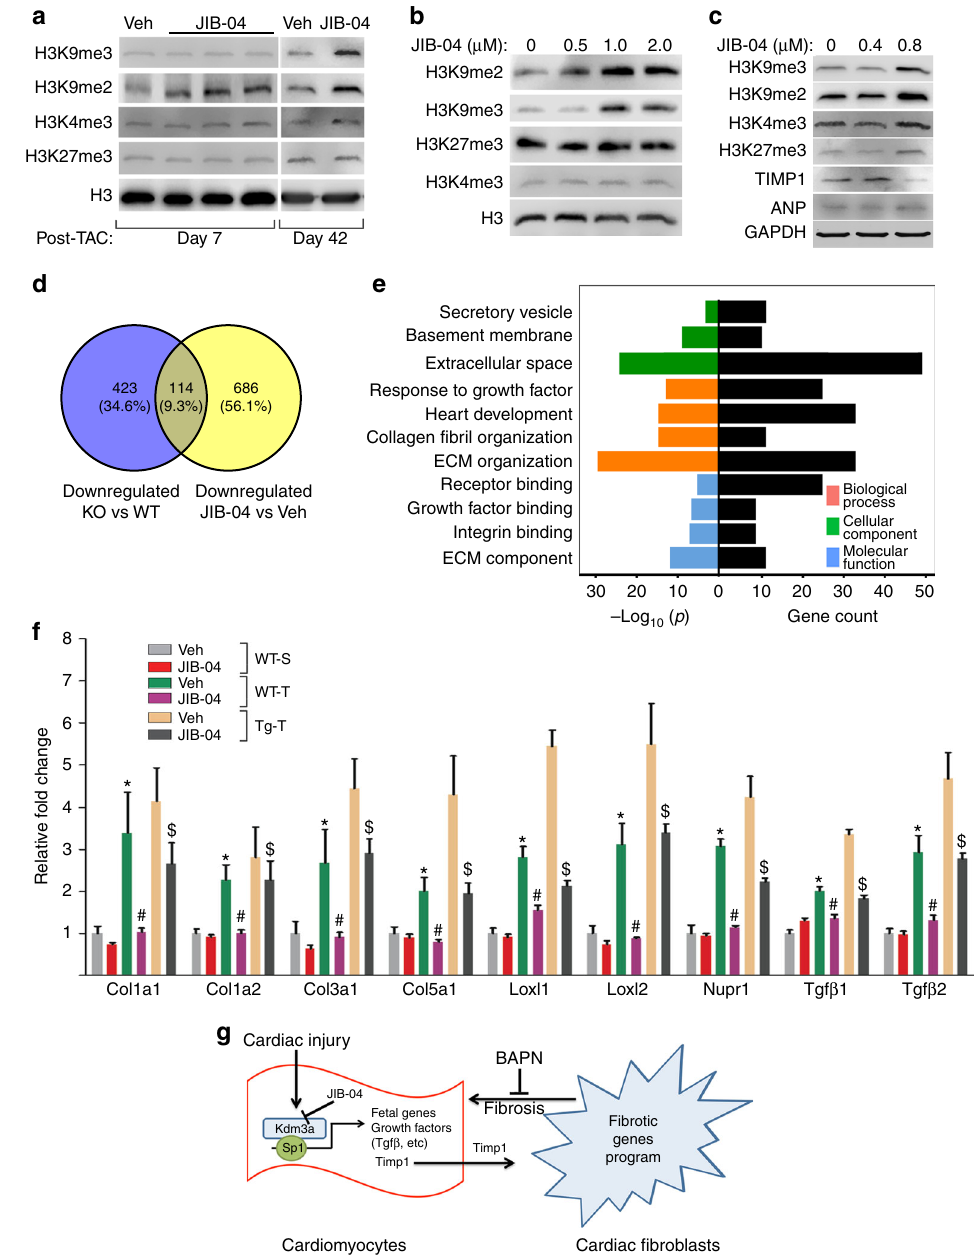
Fig. 8 JIB-04 targets H3K9me2 demethylase and fi brotic gene program. a Western blots of indicated proteins in lysates from WT mouse hearts treated with vehicle (Veh) or JIB-04 harvested at day 7 and day 42 post-TAC surgeries. b , c Western blots of indicated proteins from lysates of NRVMs ( b ) and human iPSC-CM ( c ) treated with various concentration of JIB-04. d Venn diagram showing overlapping of downregulated gene sets between KO vs WT and JIB-04 vs Veh treated mice. e GO analysis of 114 overlapping genes in d , showing signi fi cant enrichment of gene set in ECM and growth factor/integrin signaling. f qRT-PCR of representative genes in d . n = 3 ± SEM, *, # , $ , p < 0.05 (ANOVA). *, WT TAC vs WT Sham. # , JIB-04 WT TAC vs Veh WT TAC. $ , JIB-04 Tg TAC vs Veh TG TAC. g Schematics showing potential mechanism of action for KDM3A and inhibitor